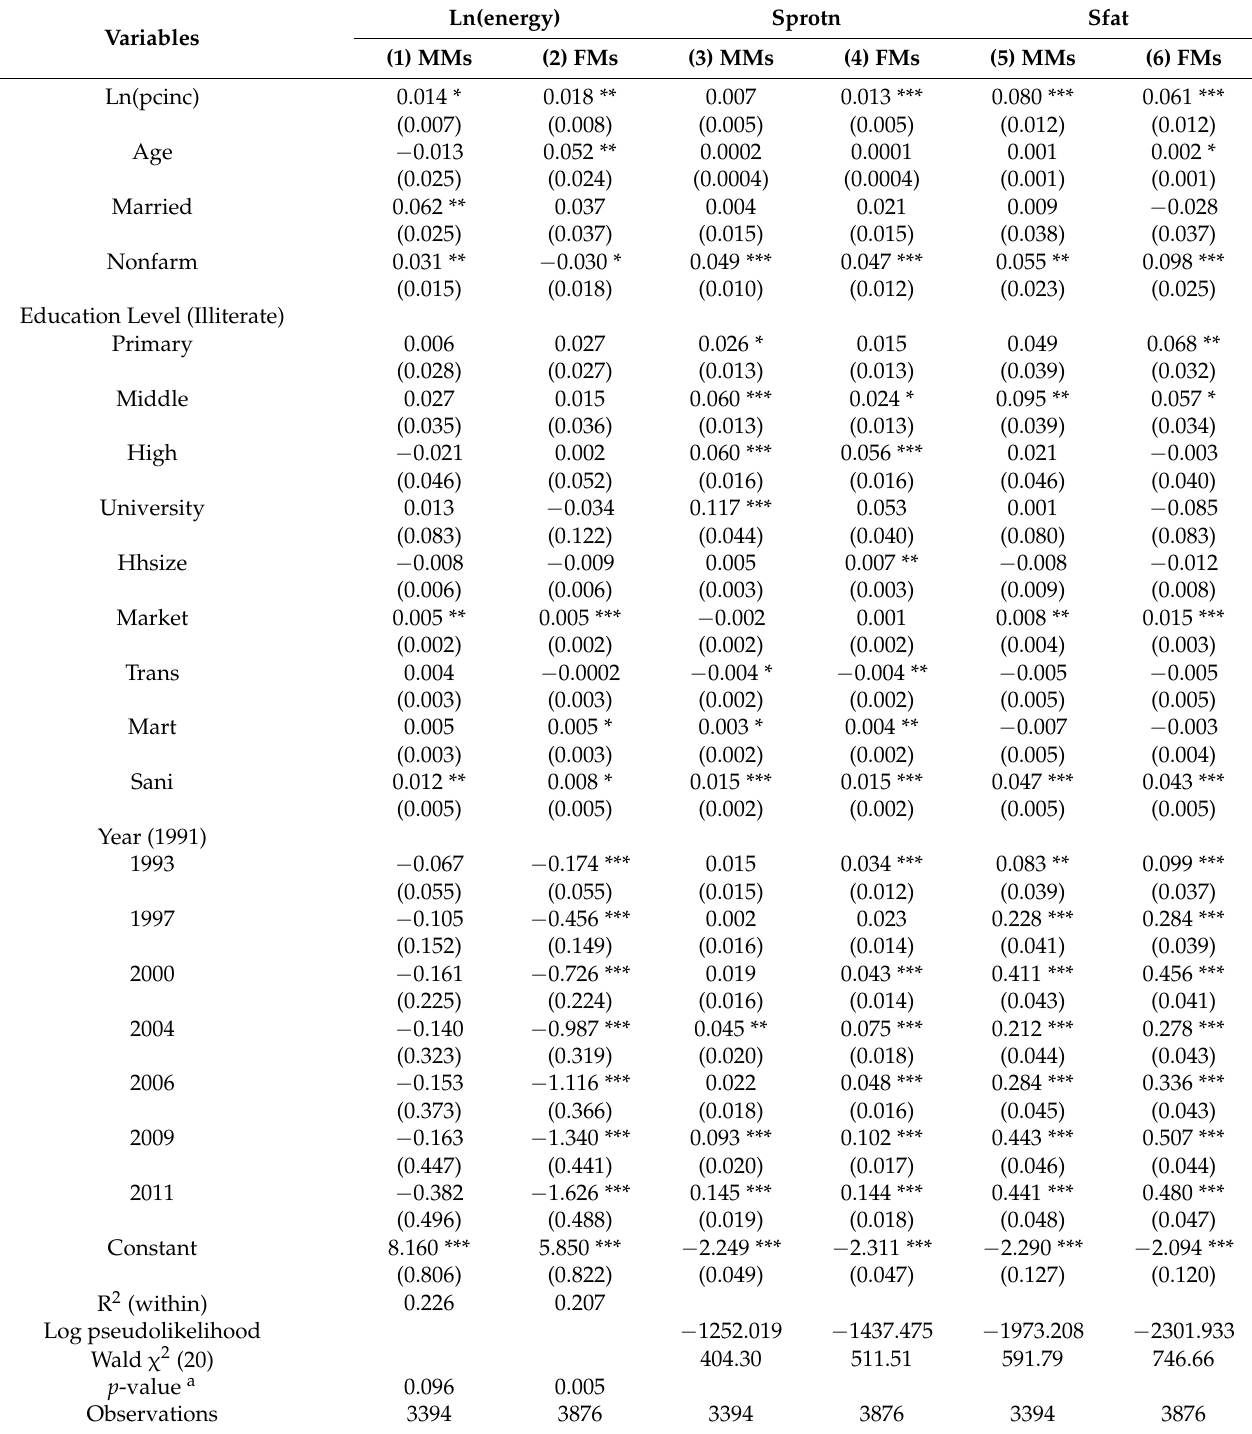
Table 4. Estimation results among migrants by male and